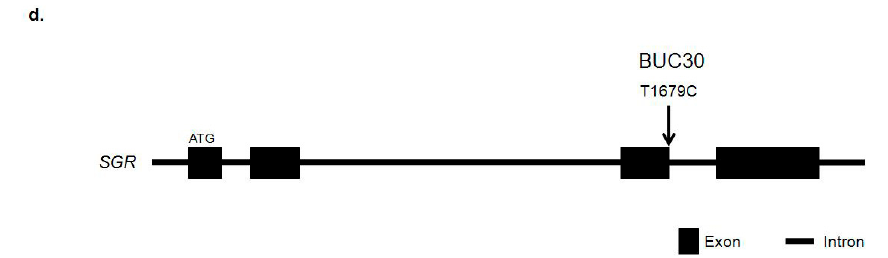
Figure 3. Alignment of DNA and protein sequences, and the position of the mutation of the SGR gene. ( a ) Sequence alignment of SGR amplified from genomic DNA of the red-fruited line (KNR3) and the green-fruited line (BUC30) compared with the reference genotype Heinz1706, showing a 1-bp substitution at position 1679 bp (highlighted in red). Alternative splicing was found in the following 31 base pairs highlighted in blue, which was confirmed in the CDS of BUC30; ( b ) Sequence alignment of SGR cDNA of the red-fruited line (KNR3) and the green-fruited line (BUC30) compared with the reference genotype Heinz1706, showing a 1-bp alteration at position 461 bp (highlighted in red) followed by a 31-bp insertion, which resulted in alternative splicing in the mRNA due to the conversion of the intron to an exon (the orange box). This insertion resulted in an early stop codon (green box inside the orange box); ( c )Amino acid alignment showing one amino acid substitution (green star) due to the non-synonymous SNP and termination of translation (red star) of the protein in the green-fruited line BUC30; ( d ) Graphical representation of the SGR gene based on the genomic sequence, where the T to C substitution is positioned at the end of the third exon.